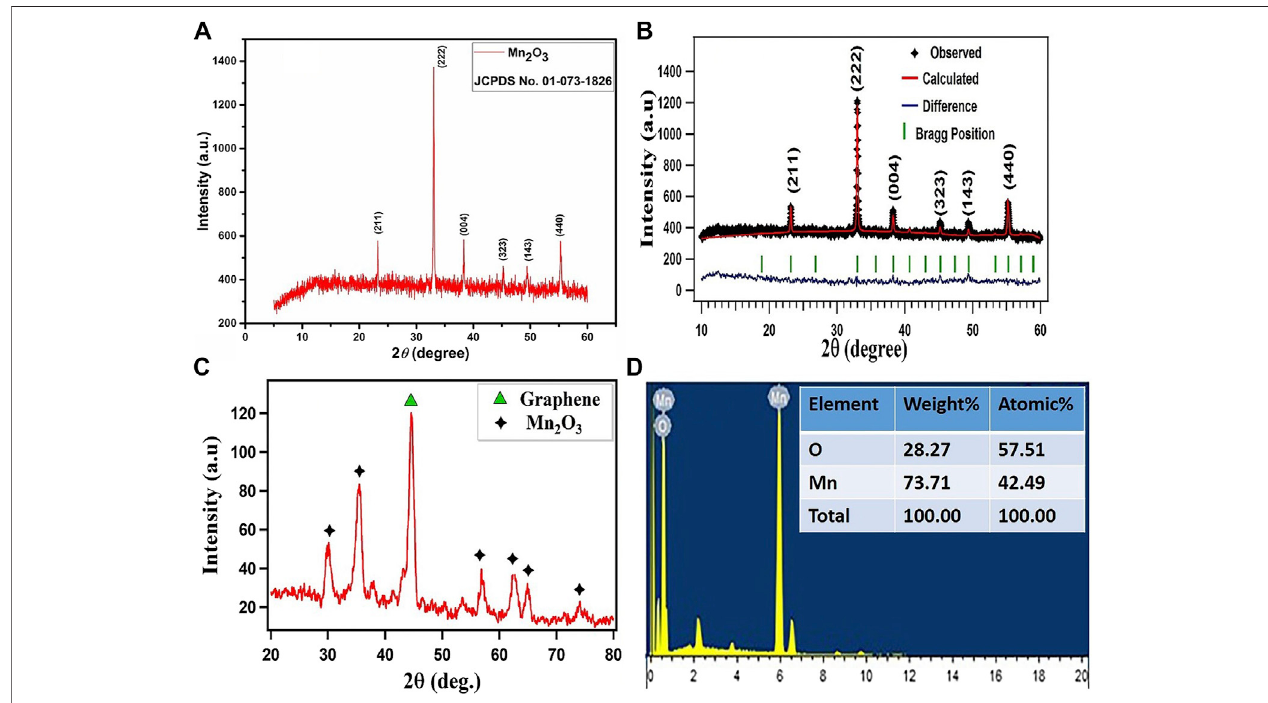
FIGURE 1 | (A,C) XRD spectra of Mn 2 O 3 nanoparticles and its composite with graphene (B) full proof re fi nement of Mn 2 O 3 (D) EDX spectrum of Mn 2 O 3 nanoparticles with compositional analysis in the inset.